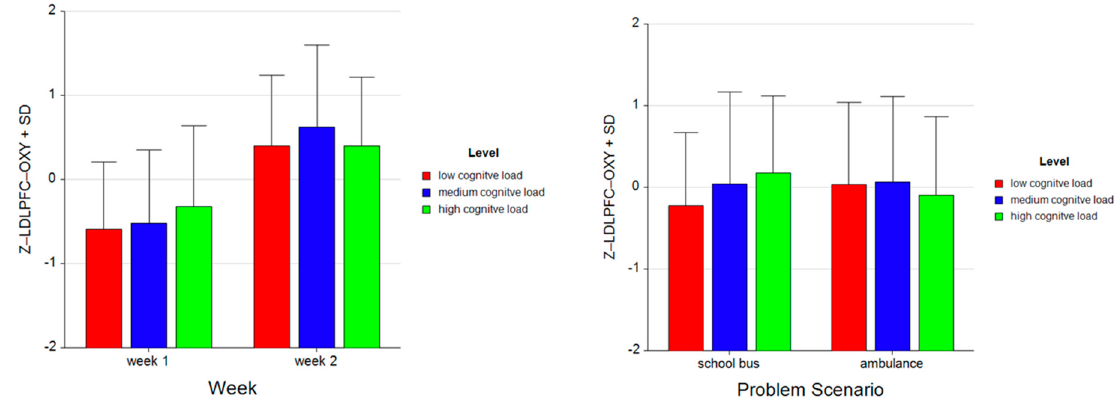
Figure 11. Bar charts represent average standardized z-scores for oxygenation for left dorsolateral prefrontal cortex (Z- LDLPFC-OXY) and standard deviation (SD) for low cognitive load, medium cognitive load, and high cognitive load tasks for experiment Week 1 and Week 2 (left) and School Bus and Ambulance problem scenarios (right).